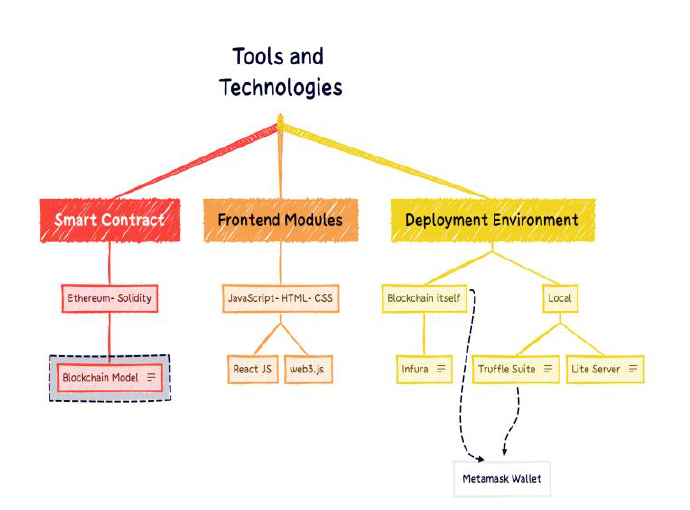
Fig. 5. Tools and Technologies used in Proposed System.